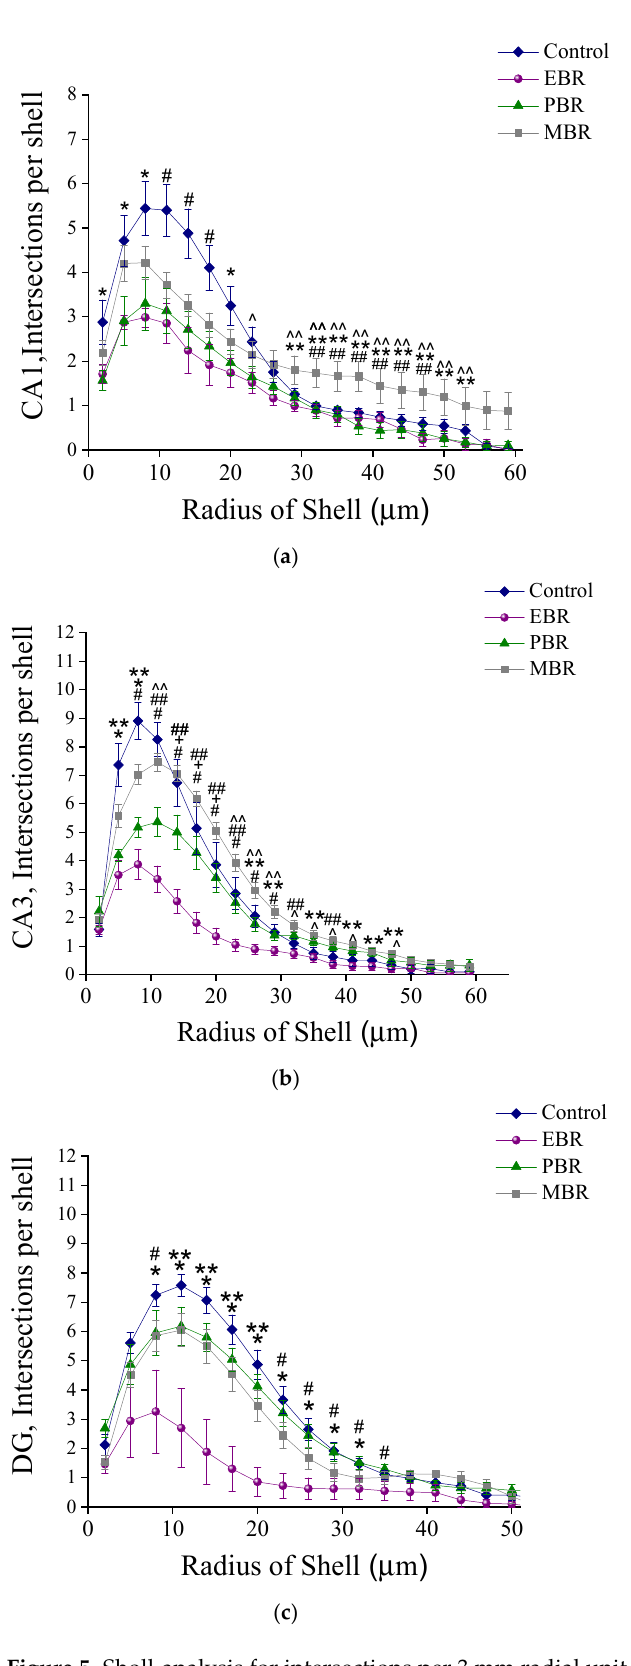
Figure 5. Sholl-analysis for intersections per 3 mm radial unit distance from sham-PSS, EBR, PBR, and MBR animals. Results displayed as mean ± S.E.M. ( a ) CA1 hippocampal subregion at day 8 post PSS-exposure: * Control ≠ EBR and PBR, p < 0.04. # Control ≠ EBR, PBR and MBR, p < 0.03. ^ Control